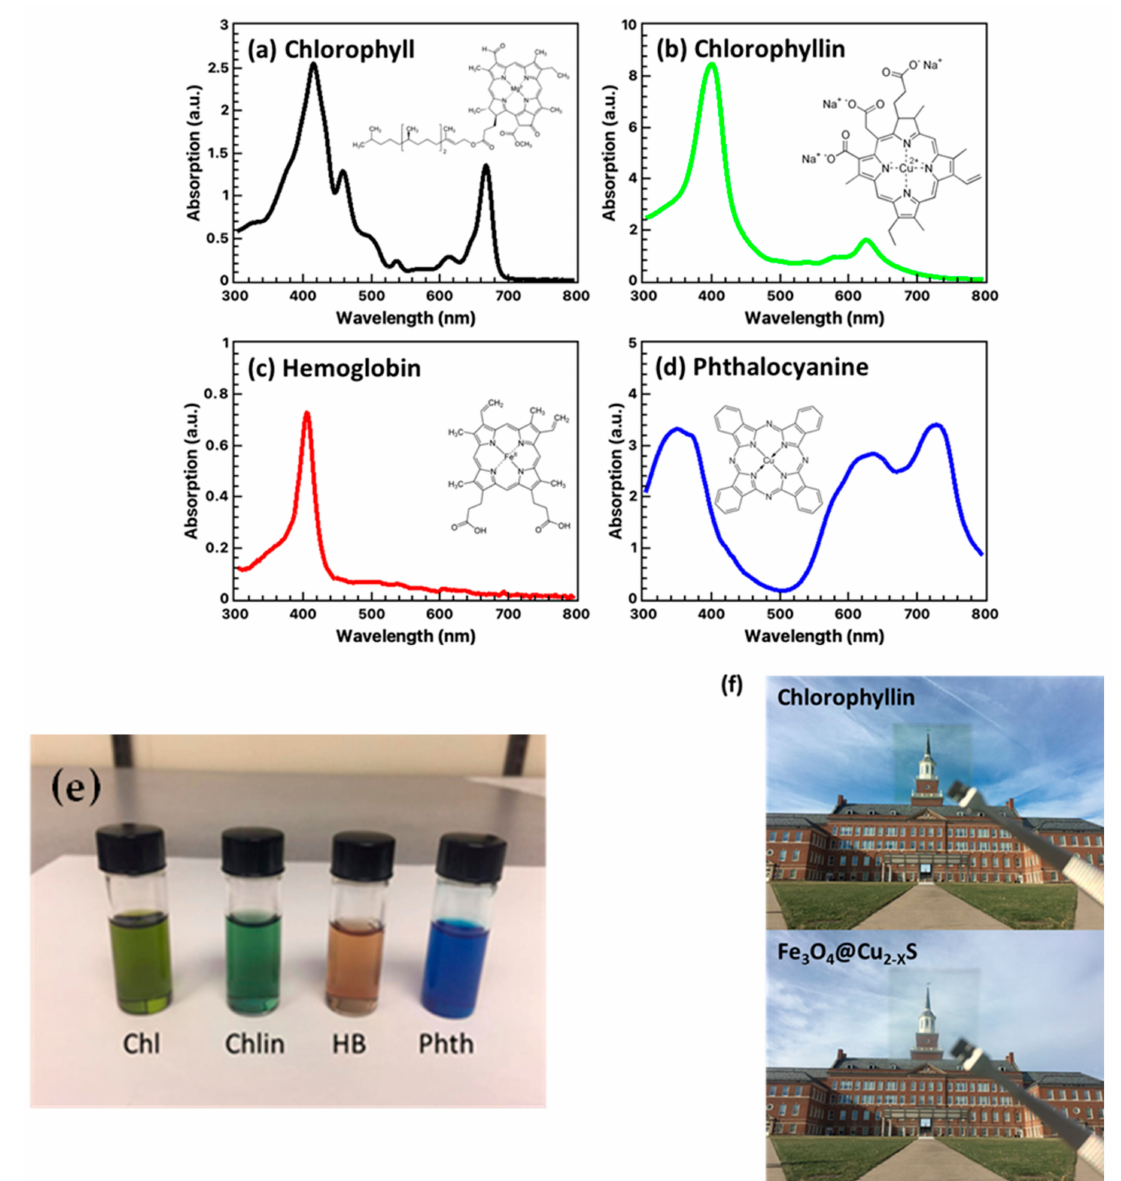
Figure 3. ( a ) Chlorophyll structure and absorption, ( b ) chlorophyllin structure and absorption, ( c ) hemoglobin and absorption, ( d ) phthalocyanine and absorption, ( e ) solutions of these porphyrin compounds, and ( f ) photographs of transparent chlorophyllin and Fe 3 O 4 @Cu 2 − x S